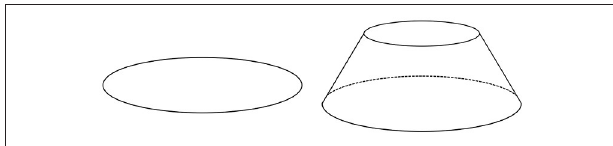
FIGURE 4 | The shapes considered: Disc (left) and frustum (right) .